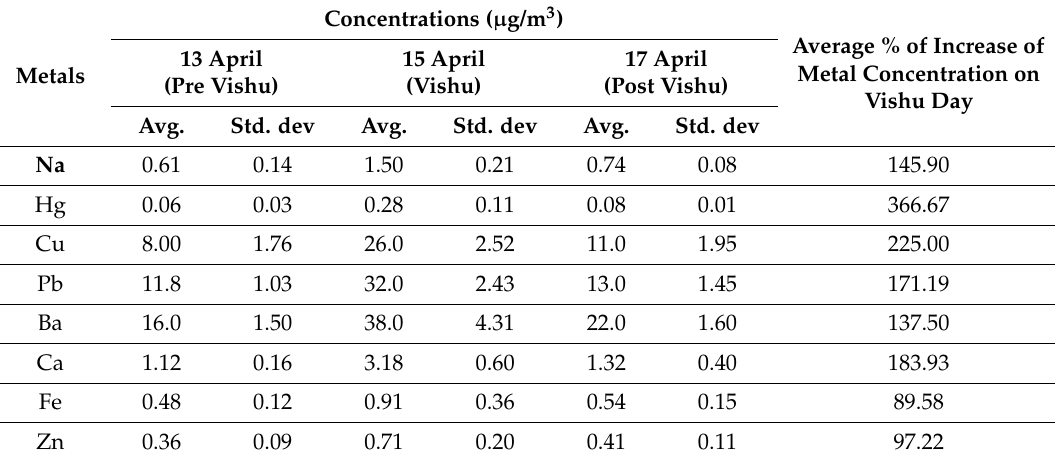
Table 3. Twenty-four hour average concentrations of different metals in ambient air of Kannur during pre-, post-, and Vishu days for the years 2015, 2016, 2017, and